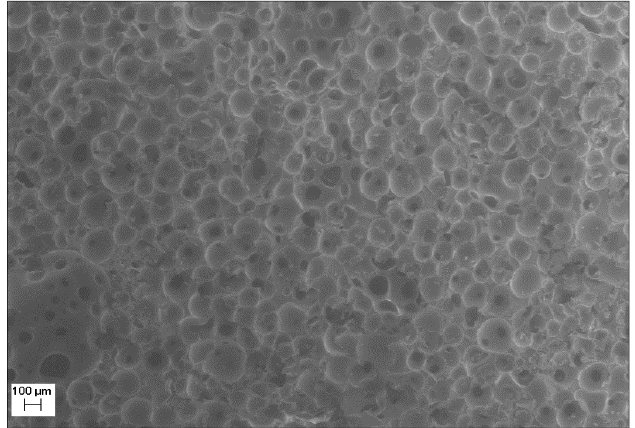
Figure 13. SEM micrograph of the foam sample (magnification 30x).